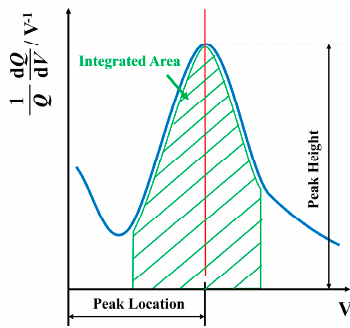
Figure 12. Quantifying the features of IC peak for further online SOH estimation. Table 3. The accuracy of the recommended SVR algorithms in capturing the feature of the characteristic peaks (peak location and height) in the IC curves.